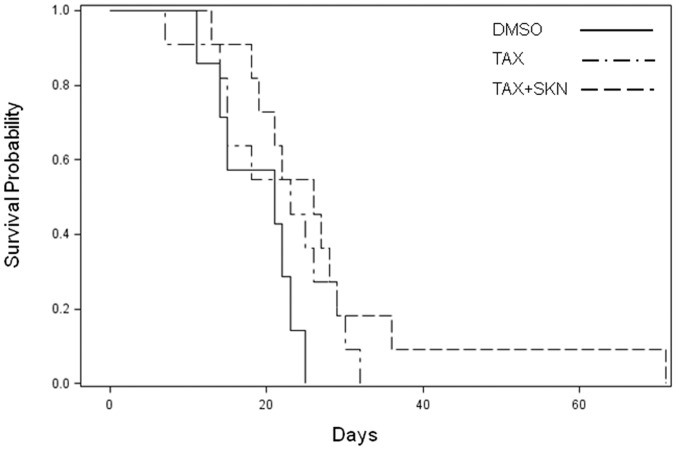
Survival probability of MD-MB-231 tumor xenografted mice.MD-MB-231 cells were transplanted into the animals. When tumor size reached 300 mm3, mice were randomized to receive a single i.p. injection of DMSO (n = 7), taxol (6 mg/kg body weight, n = 11), or the combination of taxol and shikonin (1 mg/kg body weight, n = 11). p = 0.0918 when the DMSO and the combination group were compared.